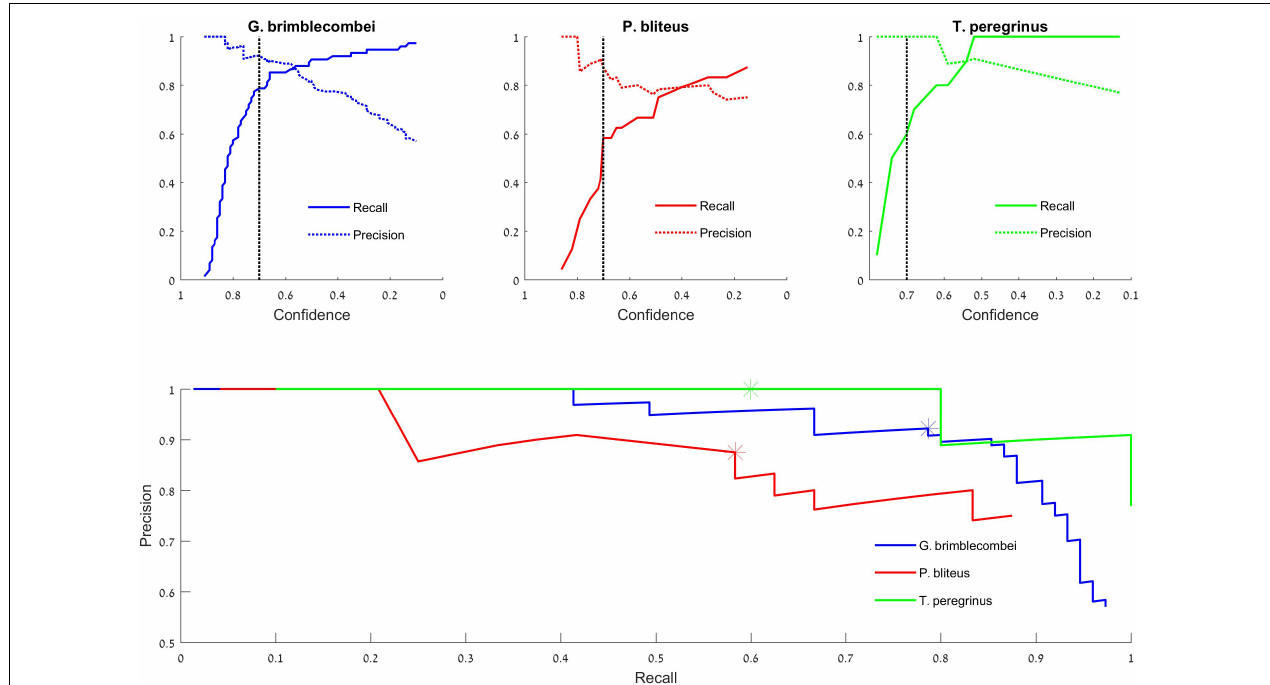
FIGURE 4 | Test set precision-recall curves. Top: the model’s success in identifying “Glycaspis” vs. “non-Glycaspis” (left), “Psyllaephagus” vs. “non-Psyllaephagus” (middle), and “Thaumastocoris” vs. “non-Thaumastocoris” (right). The plots indicate the recall and precision of the model’s predictions as a function of its confidence threshold (T cs ). The black dotted line depicts 0.7 confidence. Bottom: Recall vs. Precision curves of the three focal species. Asterisks depict a confidence threshold of 0.7. Note that the recall plots of “Glycaspis” and “Psyllaephagus” do not reach 1, as a few insects were not identified even with T cs =